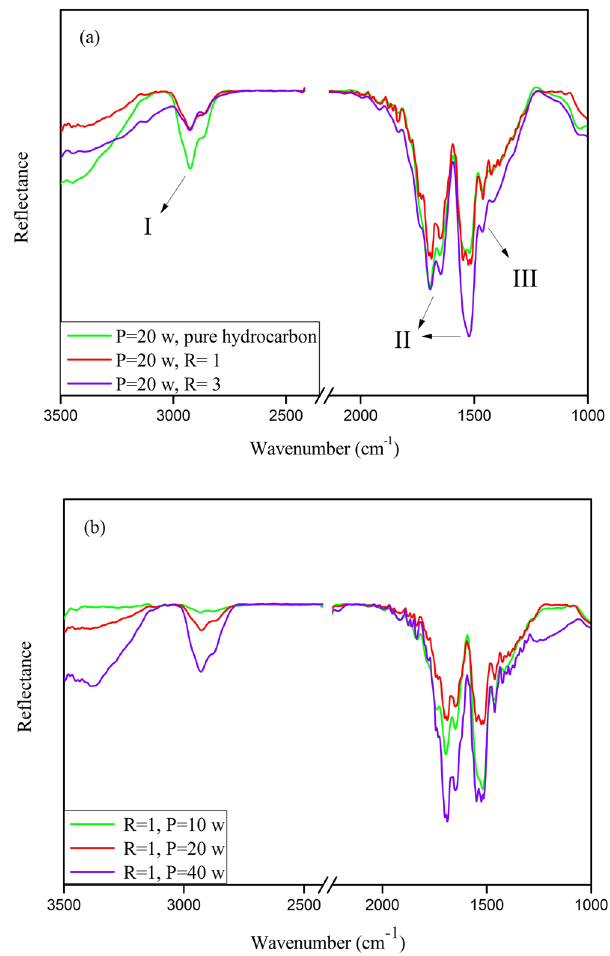
Figure 5. ATR-FTIR spectra of plasma-polymerized deposited in different ( a ) N 2 flow rates and ( b ) RF